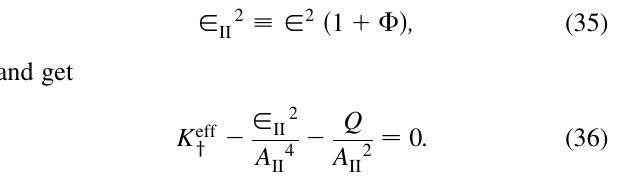
from Eqs. (47)–(49). V ranges from 5 to 22 kV. Q 0